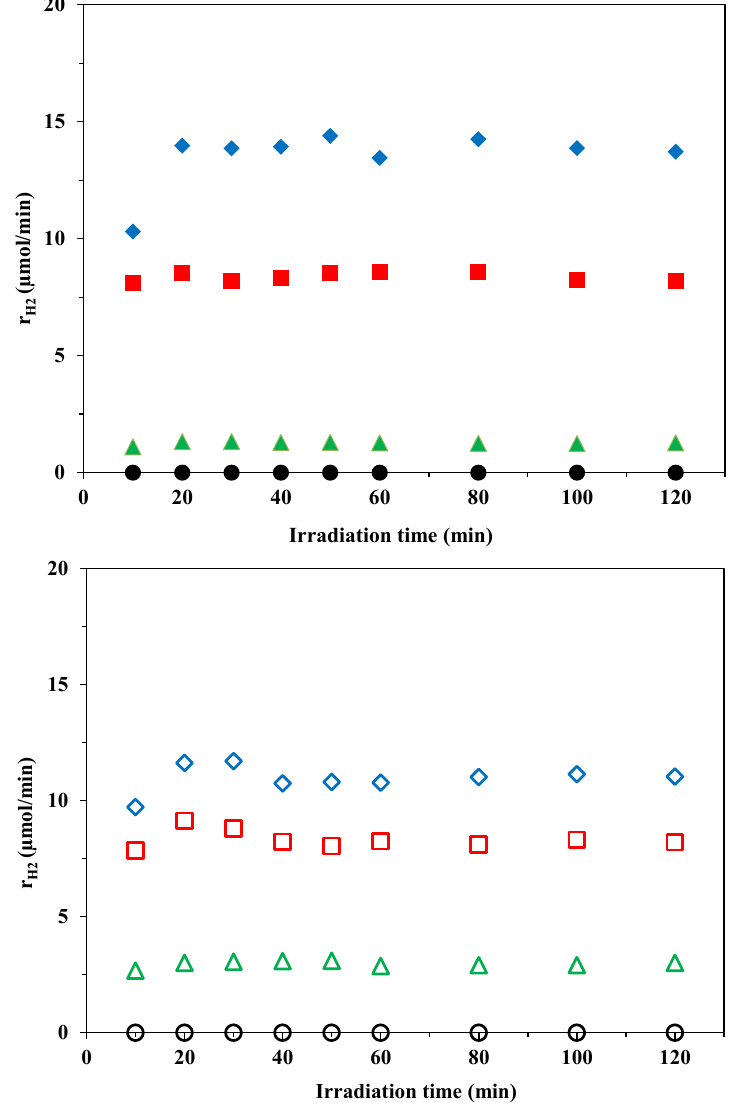
Figure 6. Comparison of H 2 evolution rates as a function of irradiation time on bare TiO 2 , PR Au-TiO 2 and the best-performing CR Au-TiO 2 catalysts (♦ Au-P25-CRIS opt , ■ Au-P25-CRSIM opt , ▲ Au-P25-PROA, ● P25; ◊ Au-Kronos-CRIS opt , □ Au-Kronos-CRSIM opt , Δ Au-Kronos-PROA, ○